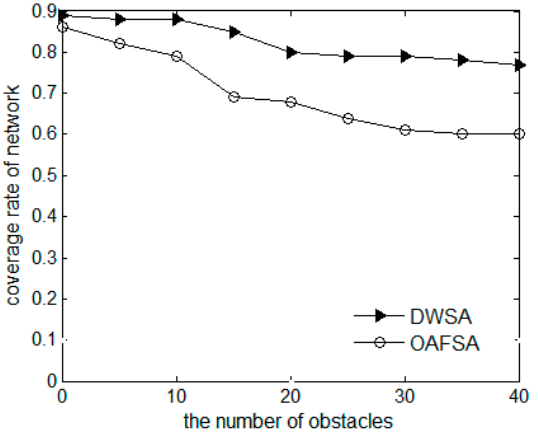
Figure 8. Comparison of network coverage rate at varying numbers of obstacles.